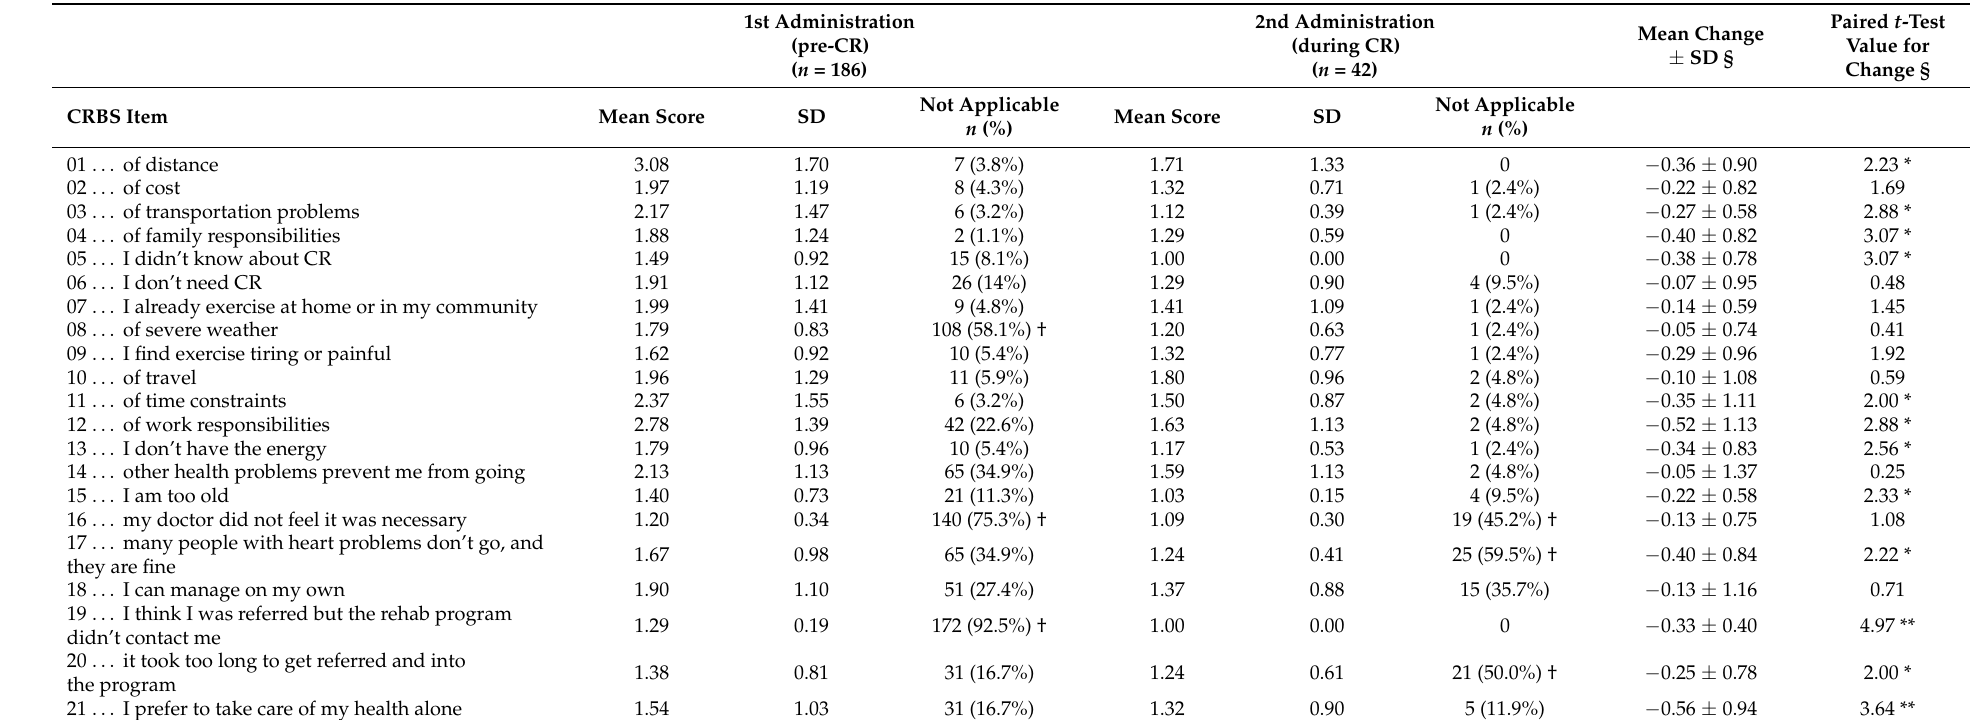
Table 2. CR barrier item scores, by assessment point and